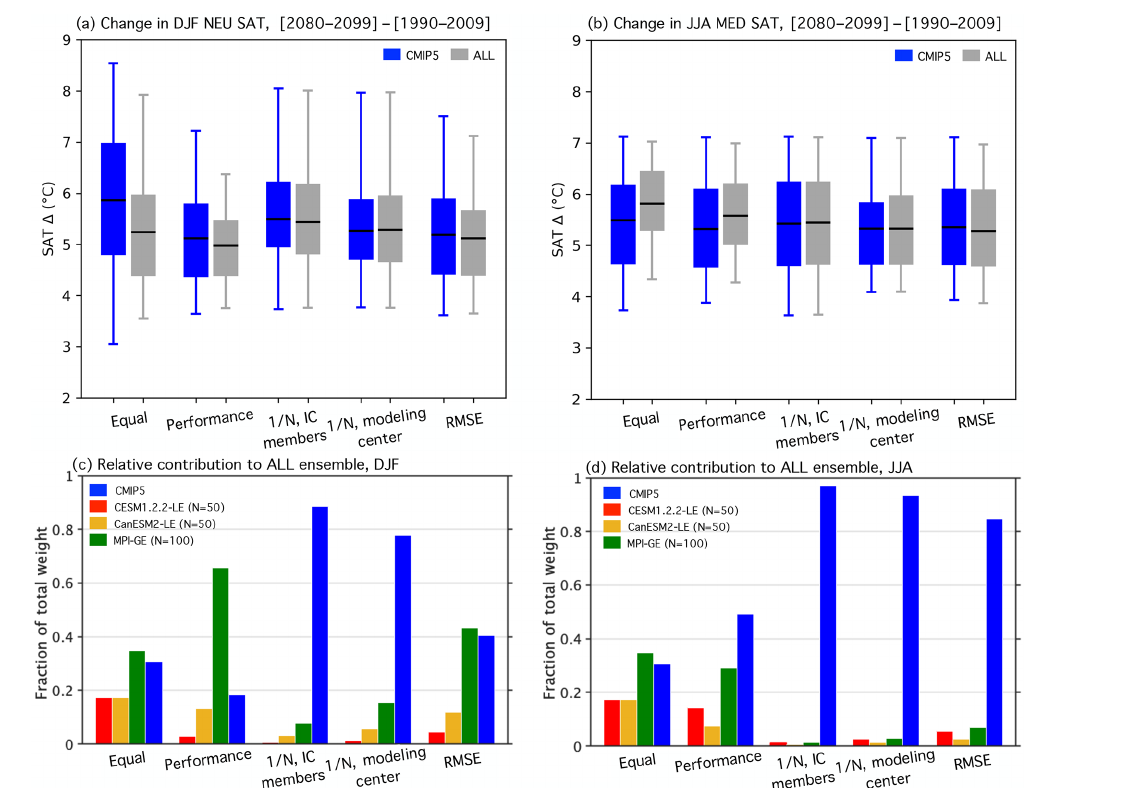
Figure 3. (a) Box-and-whisker plot showing how the five weighting strategies effect the distributions of DJF NEU SAT change ( (cid:49) , (2080– 2099)–(1990–2009)) for the CMIP5 ensemble (blue) and ALL ensemble (CMIP5 with the three SMILEs; gray). The box element spans the 25th to 75th percentile of the distribution; mean SAT change is indicated by the horizontal line within the box. The whisker element spans the 5th to 95th percentile. (b) As in (a) , but for JJA MED SAT change. (c) The contribution of SMILE and CMIP5 members to the DJF NEU ALL ensemble under different weighting strategies in terms of fraction of total weight. (d) As in (c) , but for the JJA MED ALL